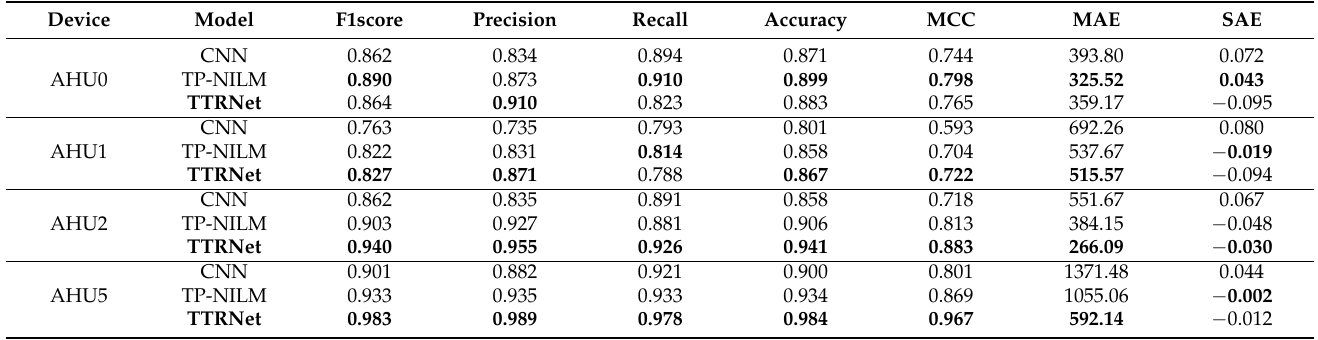
Table 10. Performance comparison of different multi-label classification NILM methods in unseen scenarios. The number in bold is the largest of the three model